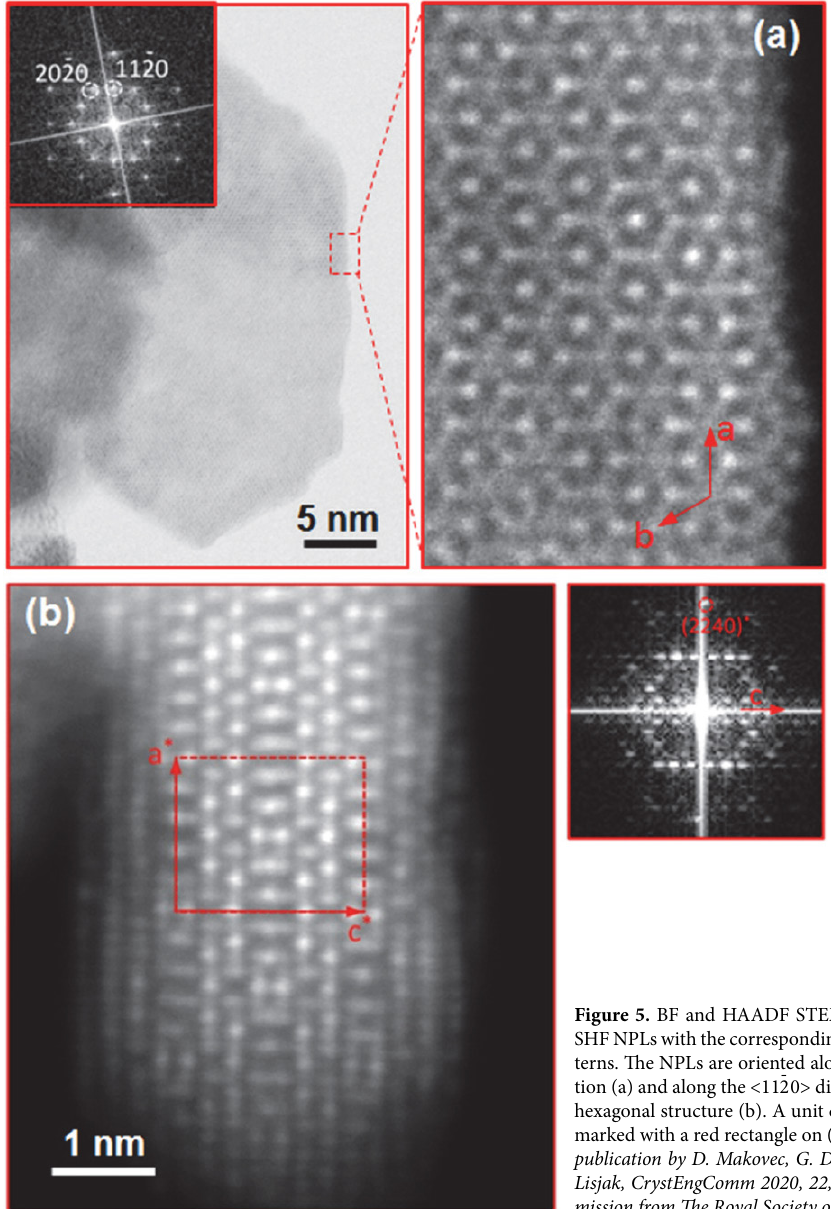
Figure 5. BF and HAADF STEM images of primary SHF NPLs with the corresponding calculated FFT pat- terns. The NPLs are oriented along the <0001> direc- <11- tion (a) and along the 2 0> direction of its complex hexagonal structure (b). A unit cell of the structure is marked with a red rectangle on (b). ( Adapted from the publication by D. Makovec, G. Dražić, S. Gyergyek, D. Lisjak, CrystEngComm 2020, 22, 7113−7122 with per- mission from The Royal Society of Chemistry. 45